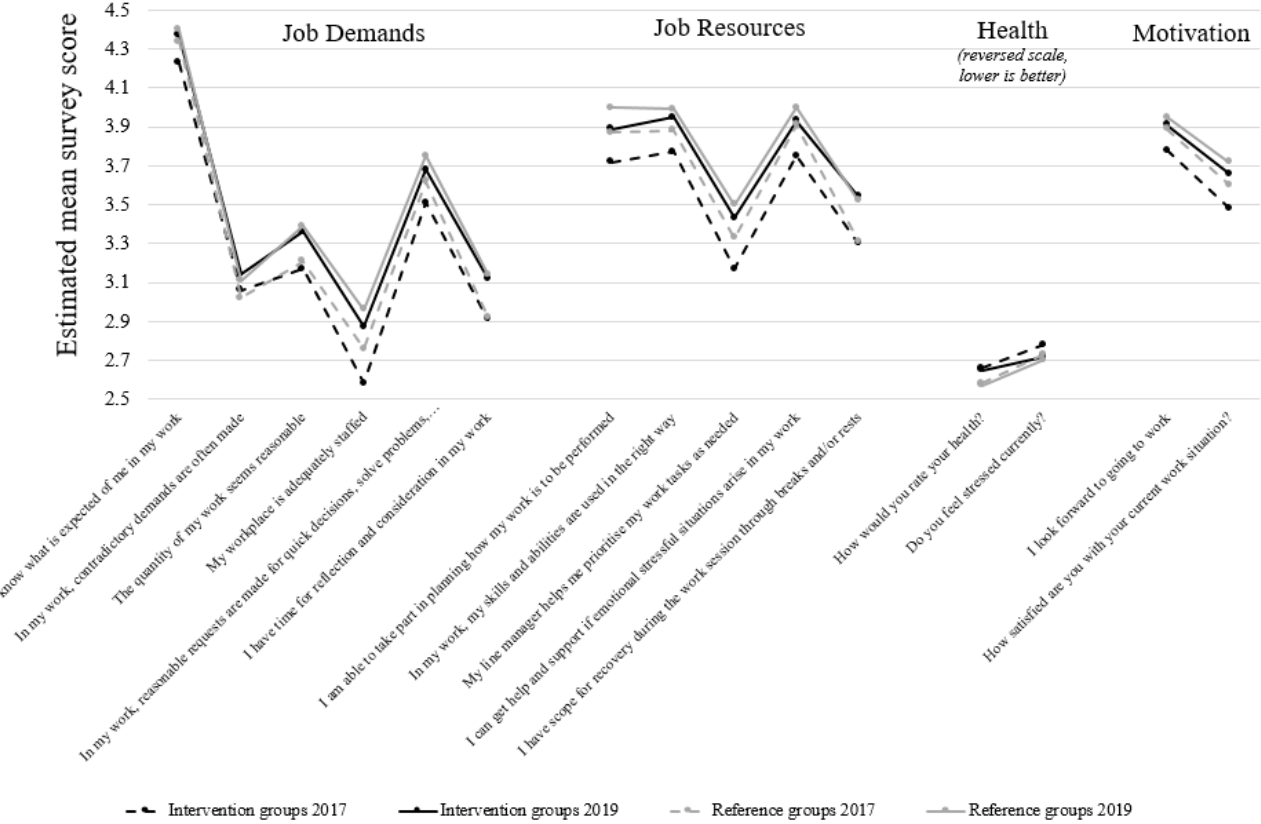
Figure 2. Estimated mean survey scores for the evaluated items representing job demands, job resources, health, and motivation, stratified by intervention status.